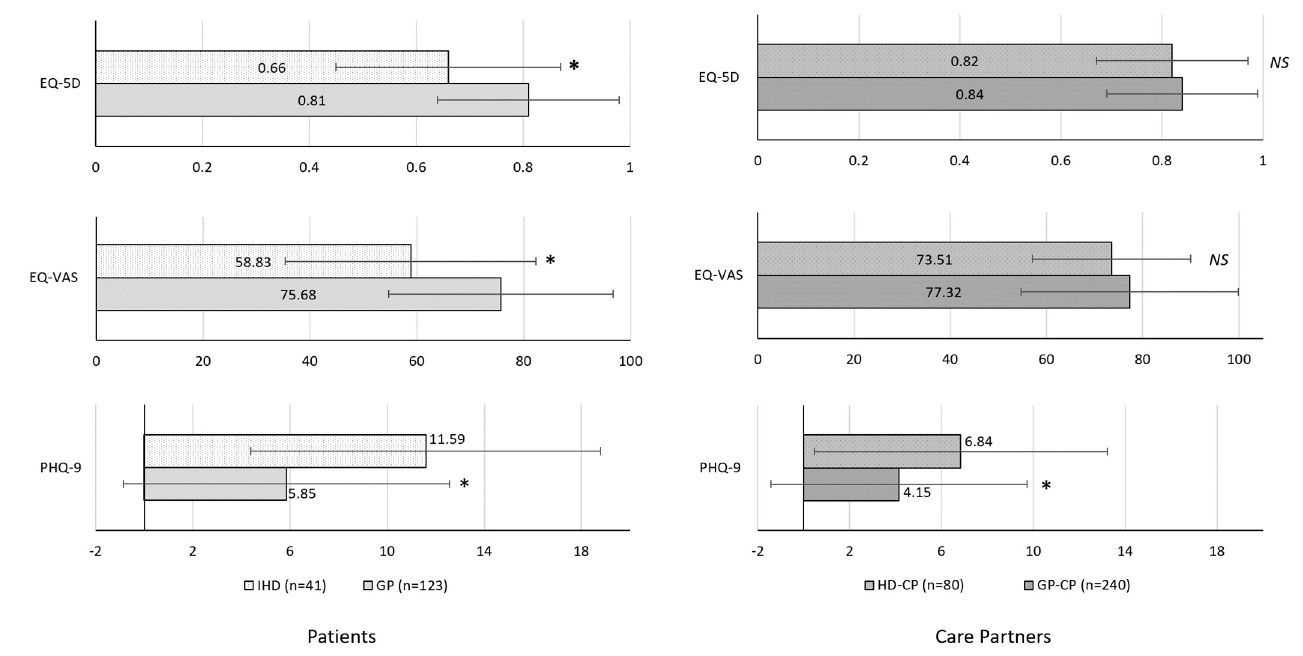
Figure 2. Impact of HD on care partners. Unadjusted data.